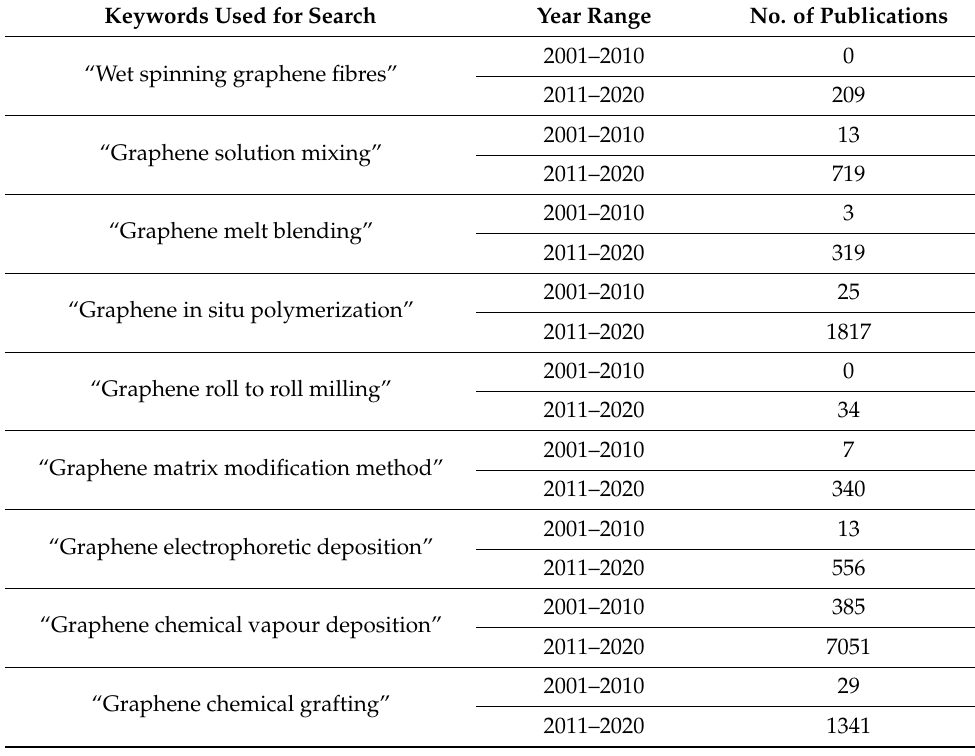
Table 2. Number of articles published between 2001 and 2020 on different production methods of graphene-based materials (Scopus, as of 10 September